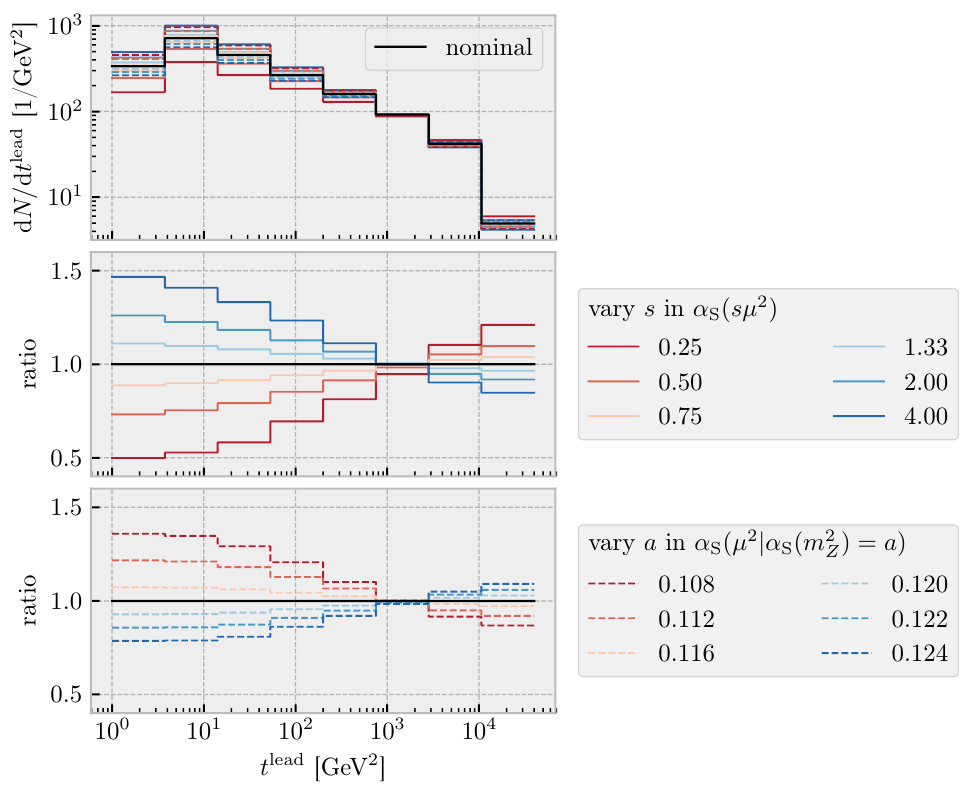
Figure 3 . The e(cid:11)ect of parton-shower (cid:11) S variations on the distribution of the leading emission scale t lead . The lower two panels show the ratios broken down into scale variations and (cid:11) S ( m 2 variations, respectively. Some intermediate variations that are used for the validation are left out here for clarity. The black line (\nominal") gives the distribution for the nominal (cid:11) S choice, i.e. for s = 1 and a = 0 :